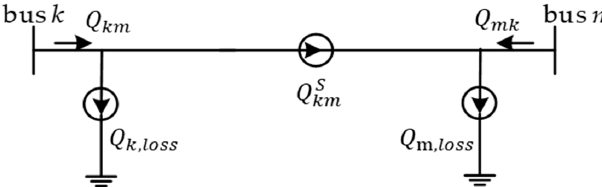
Figure 3. Transmission line reactive power flow model.